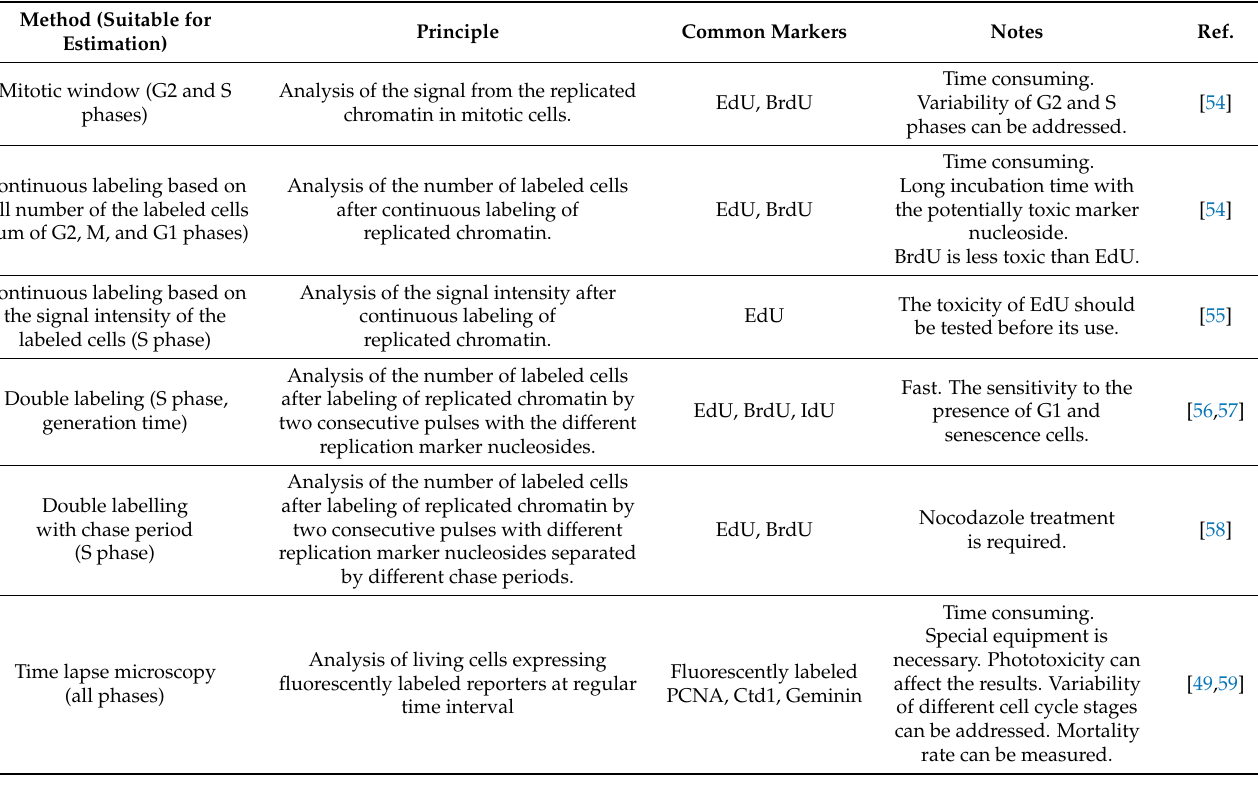
Table 1. Overview of the approaches for cell cycle evaluation based on kinetic